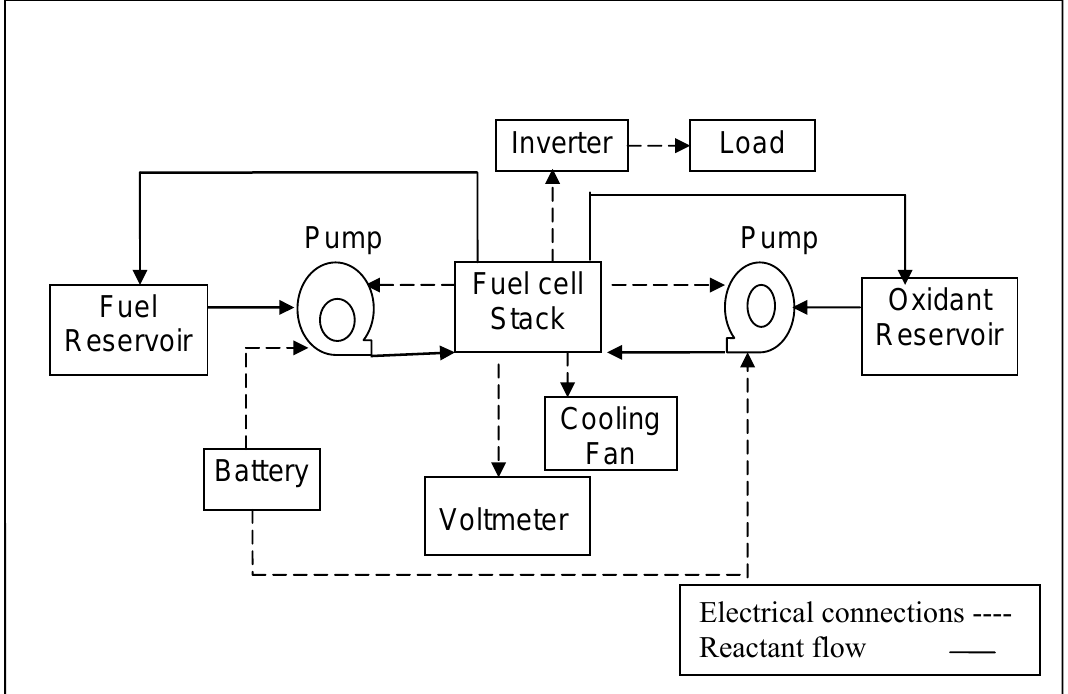
Figure 9 . Flow diagram for the 40W DBFC system along with its auxiliary